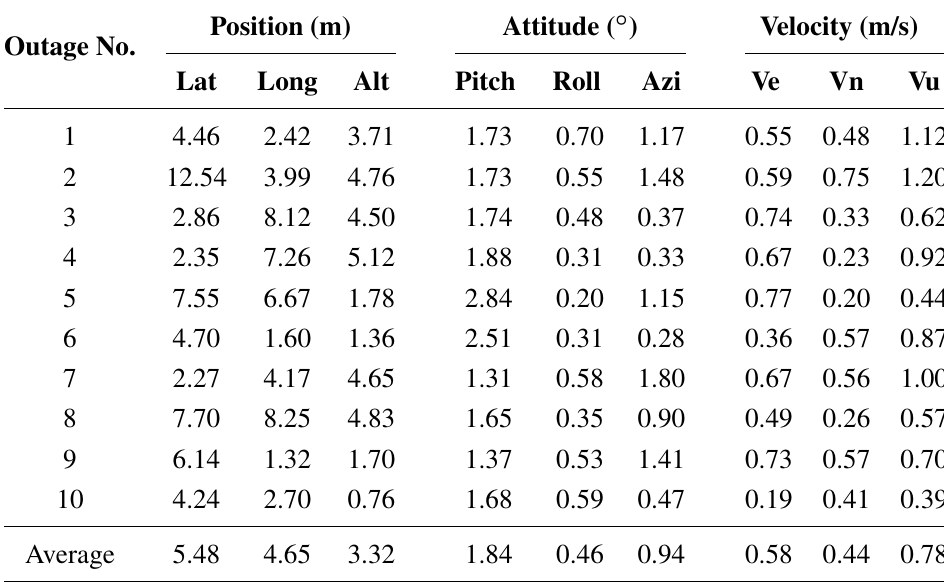
Table 2. RMS errors during full 60-second outages for the Kingston downtown trajectory. Outage